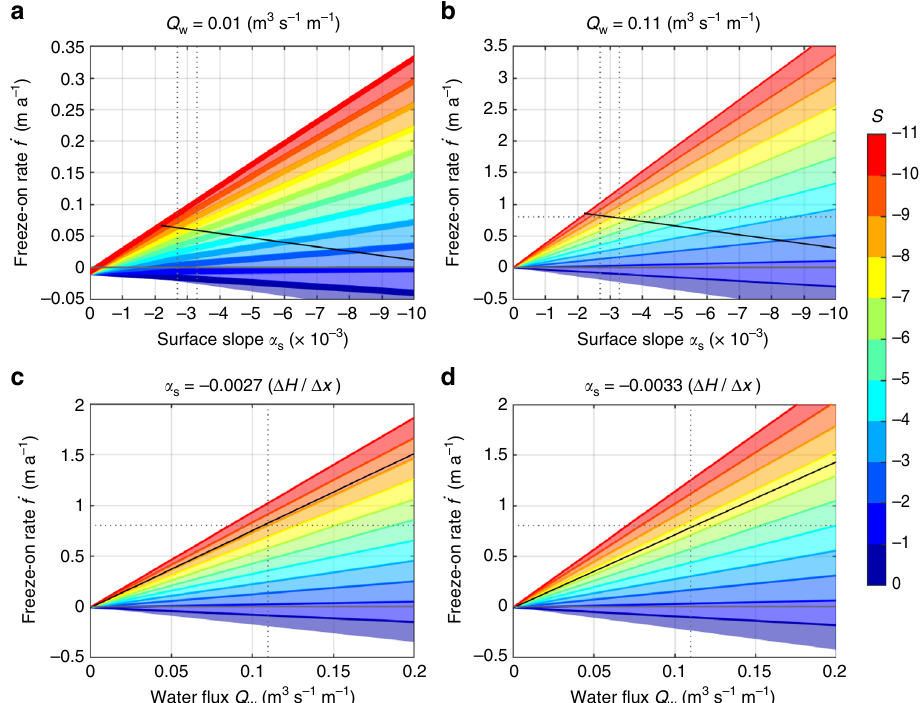
Fig. 7 Calculated freeze-on rates. Freeze-on rates calculated for a range of geothermal heat fl uxes (0.03 ≤ G g ≤ 0.11 W m − 2 ; effect of range re fl ected in the thickness of the coloured solid lines) using an ice velocity u s = 10 m a − 1 and an ice thickness H = 2200 m. a , b Freeze-on rate _ f for a constant water fl ux Q w and various bed-to-surface-slope ratios S (colour range) over a range of surface slopes α s (grey vertical dashed line for both α s = − 2.7 × 10 − 3 and α s = − 3.3 × 10 − 3 as used in c , d ). c , d _ f for a constant α S over a range of Q Q = 0.11 m 3 s − 1 m − 1 as used in b ). s and various w (grey vertical dashed line for w Freeze-on rate _ f ¼ 0 : 8 ma (cid:2) 1 (grey horizontal dotted line) and fi xed bed slope α b = 0.025 (black solid line), as calculated for the plume in Fig. 3a, b (see Methods sections ‘ Basal freeze-on rates for plane fl ow ’ , ‘ Estimate of basal meltwater ’ and ‘ Estimate of freeze-on rate and water fl ux ’ ). Note the different scales for _ f , and how the surface slope affects _ f along a fi xed bed in c ,